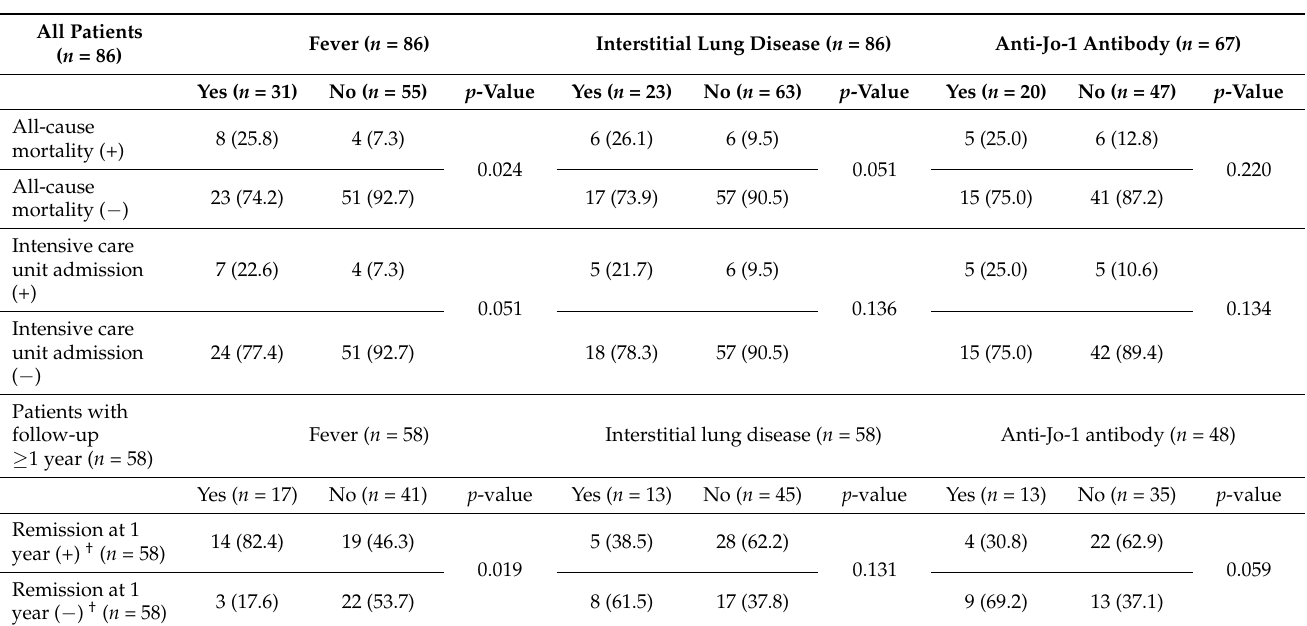
Table 3. Outcomes according to the presence and absence of fever, interstitial lung disease and anti-Jo-1 antibody.